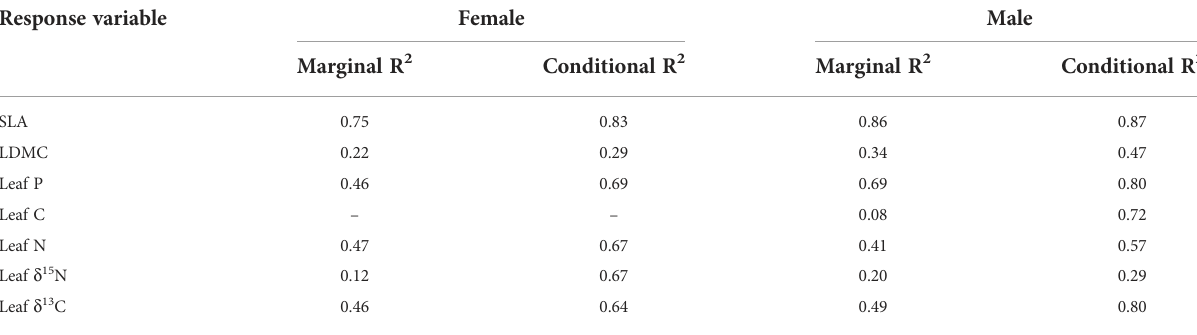
TABLE 3 The marginal R 2 and conditional R 2 of the structural equation model in functional traits of female and male T. fuana . Response